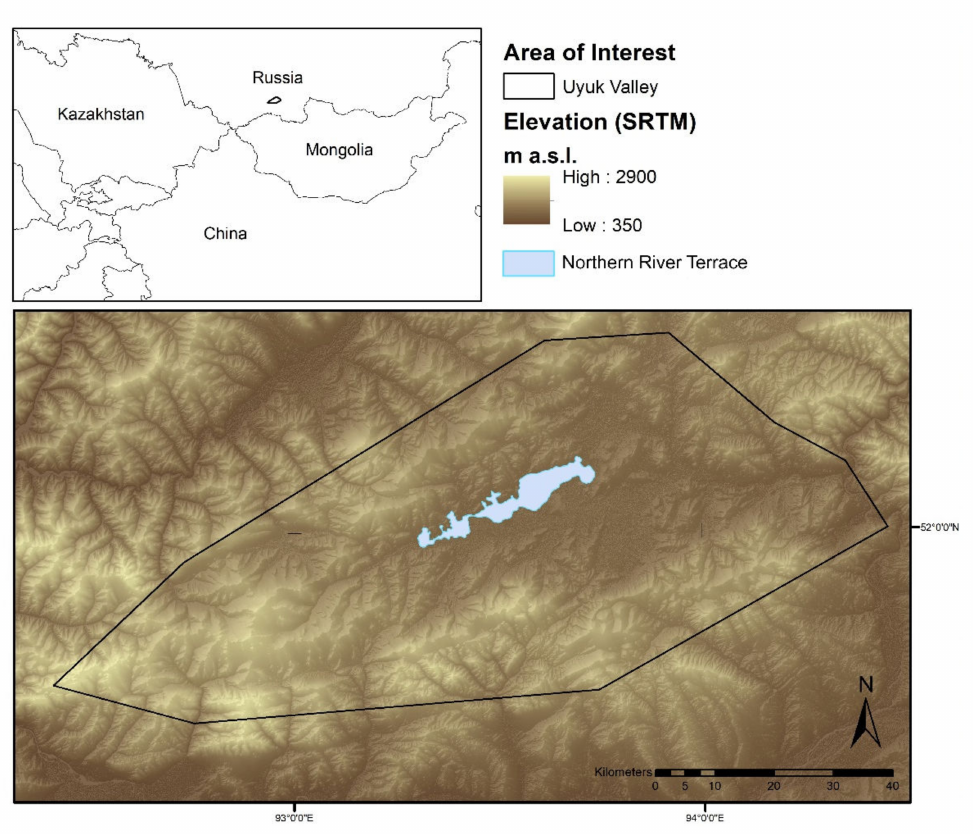
Figure 1. The area of interest in the Valley of the Kings in Tuva Republic, Russian Federation. The size of the area of interest on the northern river terrace measures 100 km 2